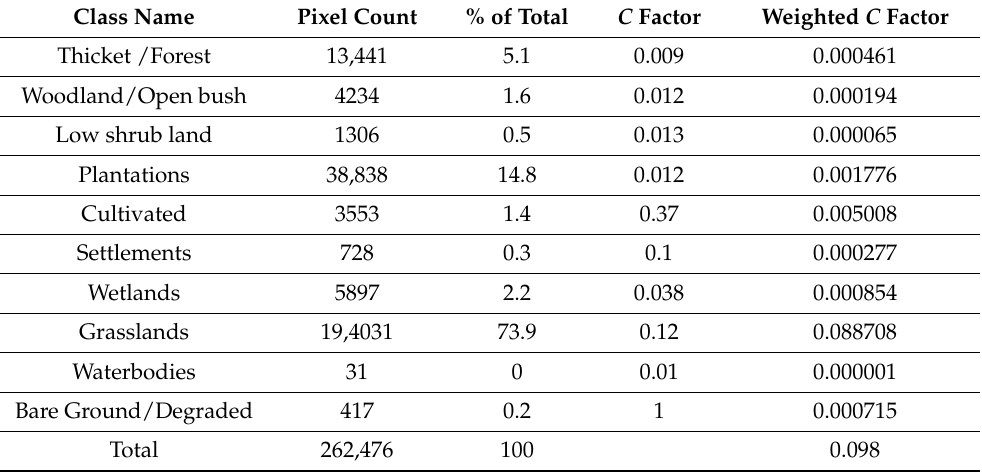
Table 2. Fixed catchment (T35C) C factor calculated using maps and values from the